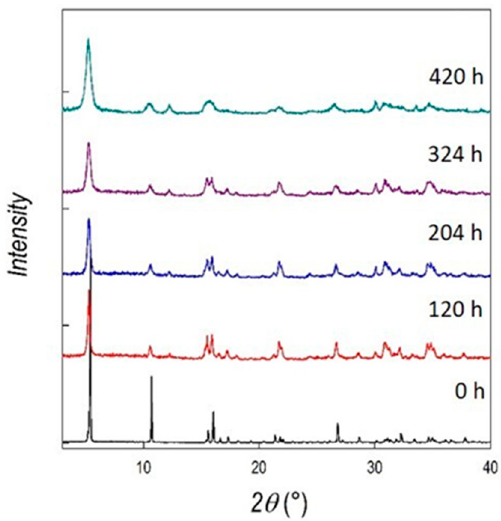
Figure 2. XRD patterns of PEA 2 PbI 4 (PEA = phenylethylammonium) as a function of ball-milling time. Representative SEM images of the as-prepared and after-ball-milling MAPbI 3 and PEA 2 PbI 4 samples are respectively reported in Figures 3 and 4.